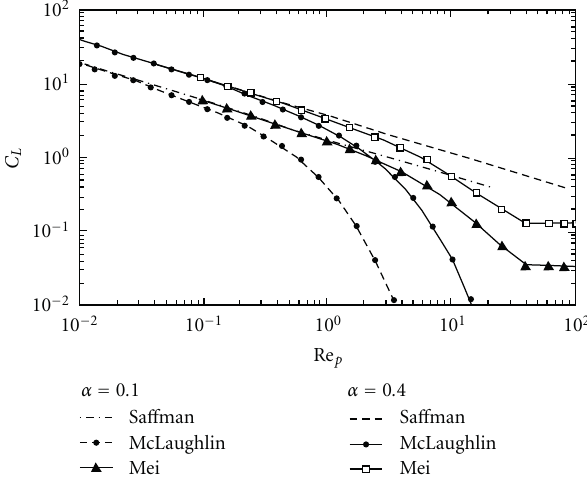
Figure 9: Graph of shear coe ffi cient versus Reynolds number based on the analyses of Mei [59], McLaughlin [69], and Sa ff man [36], reprinted from Mei [59], Copyright 1992, with permission from